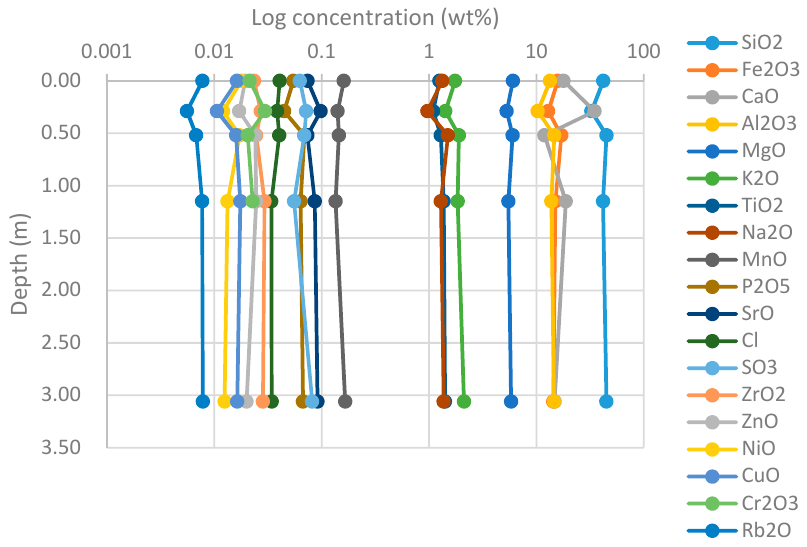
Figure 6. X-ray fluorescence (XRF) data for bentonite in borehole KM1 (normal-log plot). All depths are from the base of the overlying limestone.